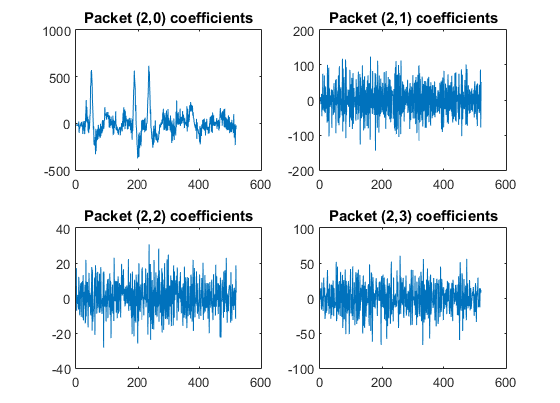
Fig. 7. 2nd level decomposition coefficients